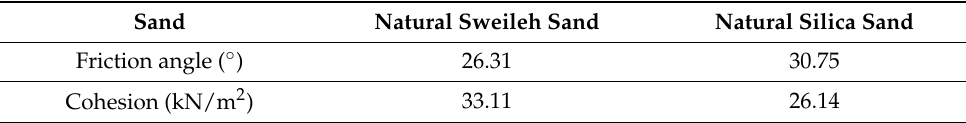
Table 1. Shear strength parameters for Sweileh and silica soils.